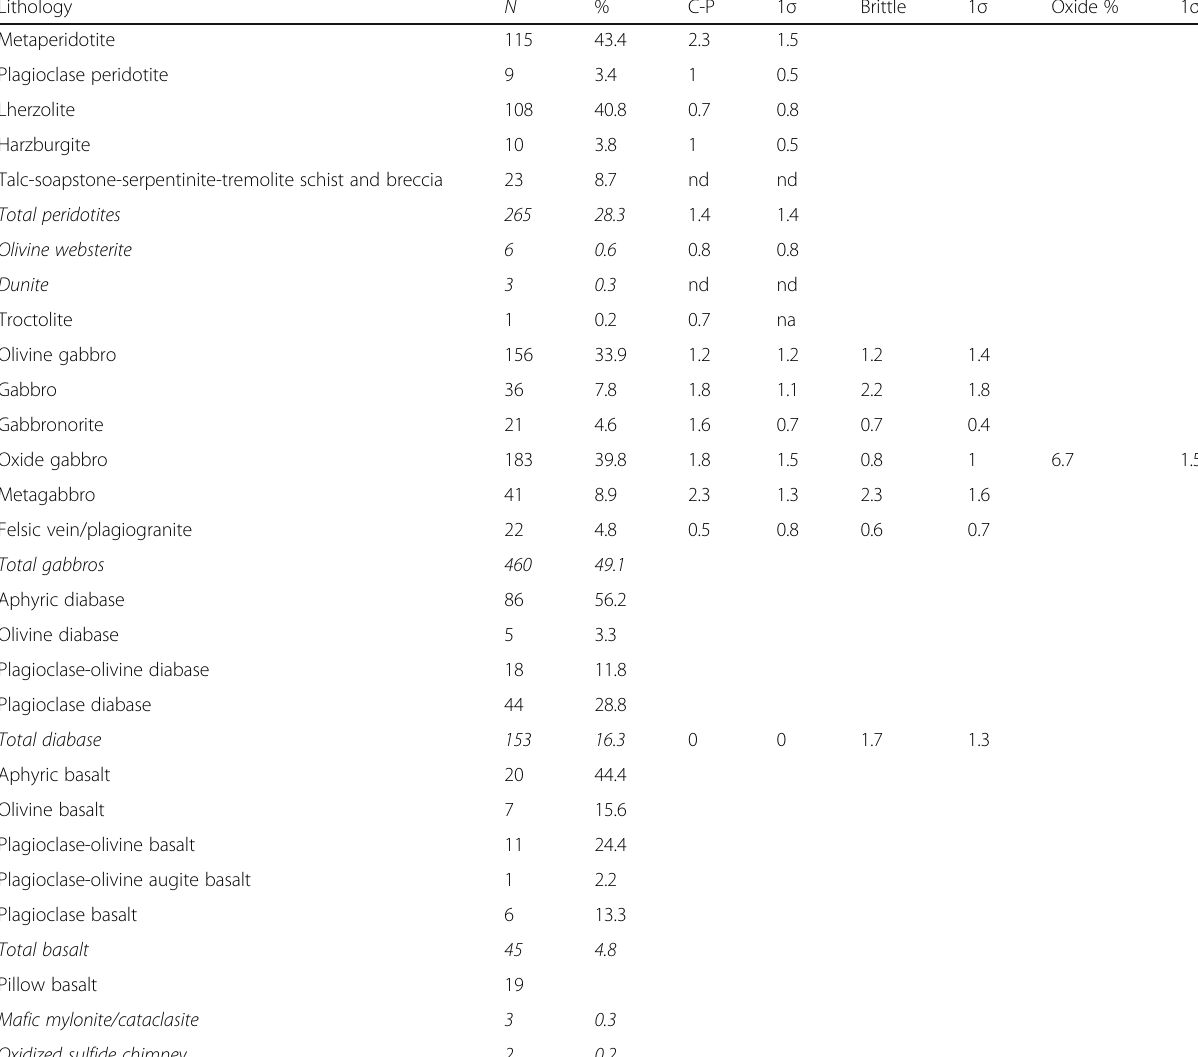
Table 2 Atlantis Bank seafloor samples ( N = 937)